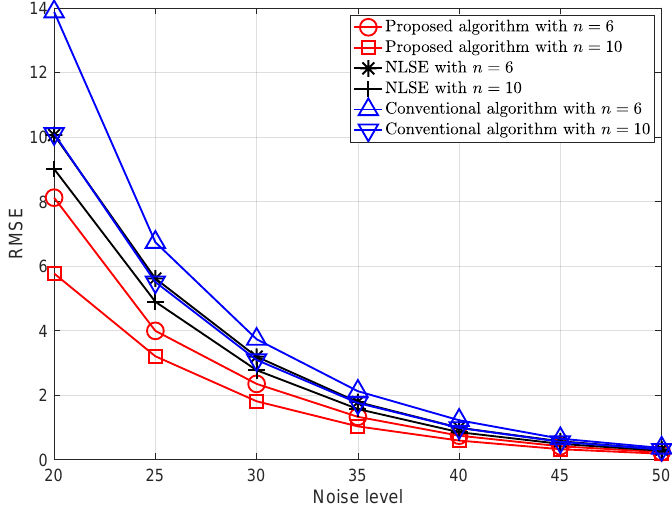
Figure 5. The Root-Mean-Square Error (RMSE) for the proposed algorithm, the NLS estimator [37], NLSE, and conventional algorithm proposed in [30,42] for different numbers of nodes and different noise